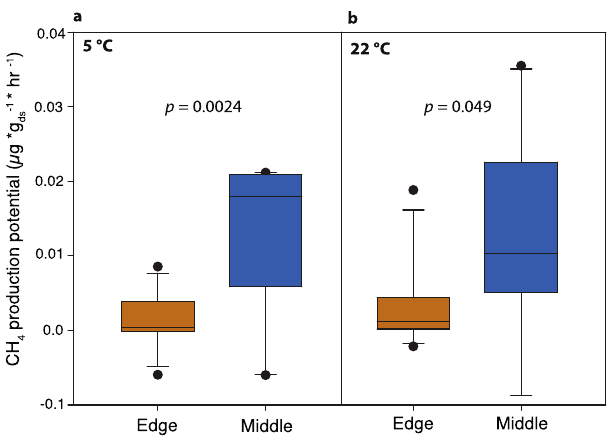
Fig. 3 Methane production from anaerobic laboratory incubations of lake sediments. Sediments were collected from edges and middles of lakes Inre Harrsjön and Mellersta Harrsjön in 2012 and 2013 (see Methods) and incubated at a 5 °C ( n = 12 independent incubation experiments) and b 22 °C ( n = 12 independent incubation experiments). Headspace CH 4 concentrations were measured daily for 5 days and average daily CH 4 fl uxes were calculated for each sample. Lines in boxes depict the median, boxes indicate 75th percentile, whiskers 95th percentile, and points are outliers. ds dry sediment. p -Values for both a and b are from one-way ANOVA edge vs. middle comparisons (signi fi cant if p <